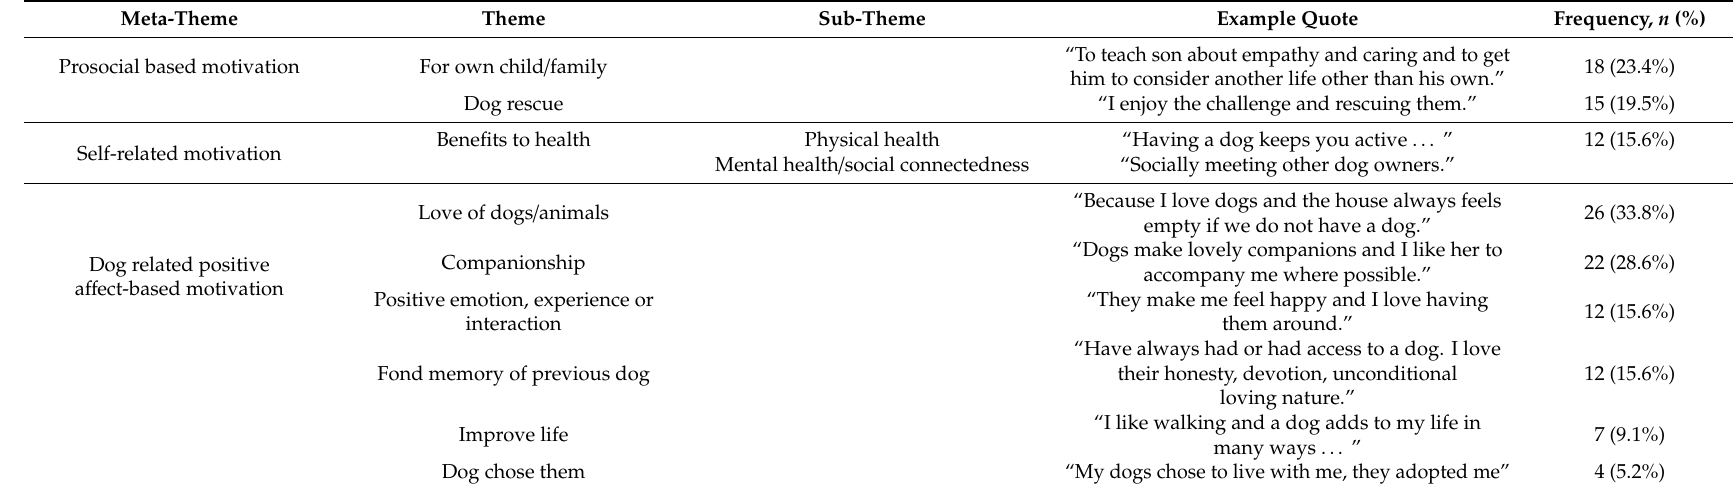
Table 9. CDO motivations for becoming a companion dog owner ( n = 77).